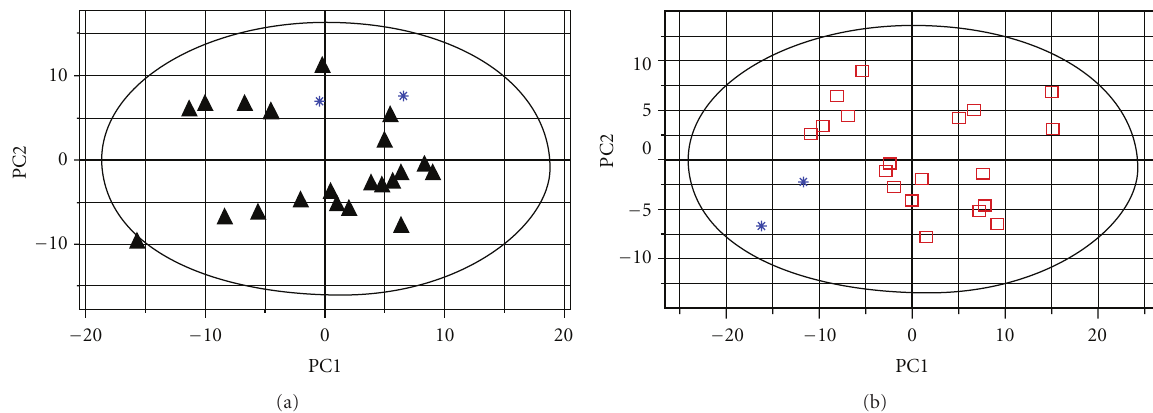
Figure 4: The plots of PCA analysis for two control pregnant mice including CP fetuses in di ff erent groups “a” showed the PCA analysis between two outliers from the control group and the data of pregnant mice with CP fetuses in DEX group; “b” showed the PCA analysis between two outliers from the control group and the data of pregnant mice with no-CP fetuses in control group.